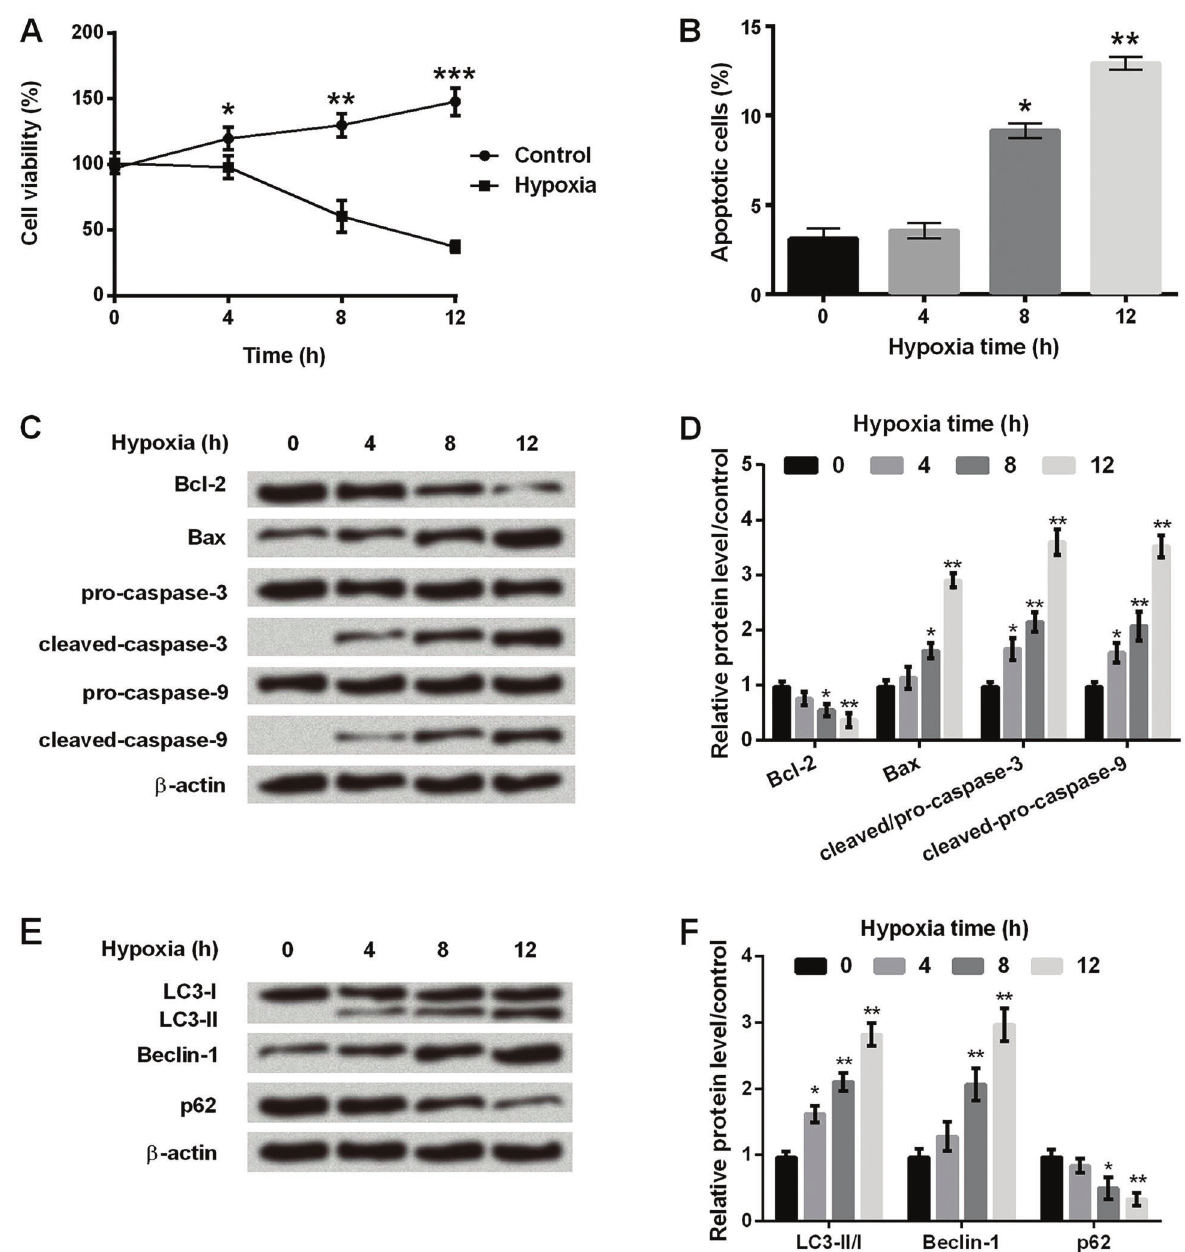
Figure 1. A , Cell viability was determined at different times in the control and hypoxia groups. B , Apoptosis rate was measured at different times in hypoxic astrocytes. C , Protein immunoblots of apoptosis-related factors by western blot assay. D , Relative expressions of apoptosis-related factors by quanti fi cation of band intensity. E , Protein immunoblots of autophagy-related factors by western blot assay. F , Relative expressions of autophagy-related factors by quanti fi cation of band intensity. b -actin acted as an internal control. Data are reported as means ± SD. *P o 0.05, **P o 0.01, ***P o 0.001 compared to 0 h